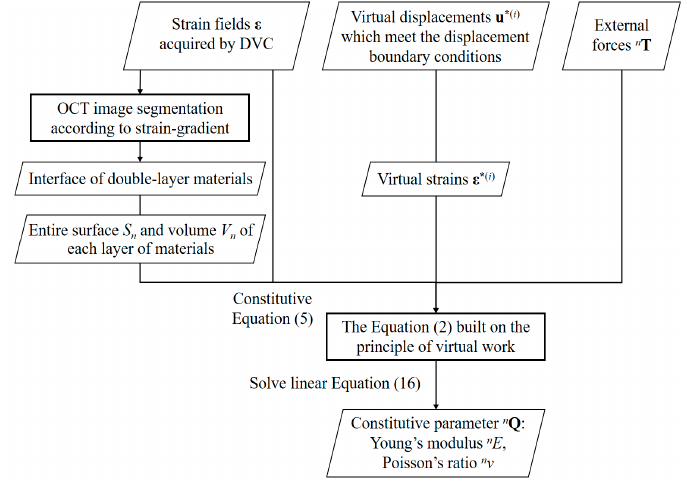
Figure 2. A flow chart of the layered VFM.